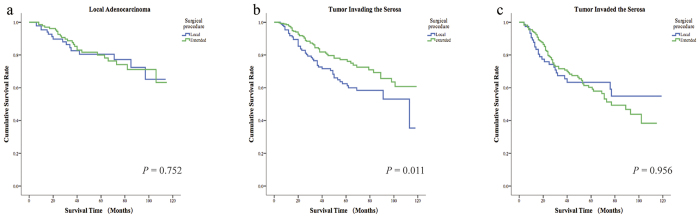
5-year overall survival of different surgical procedure according to different depth of tumor invasion.(a) For tumor did not invade the serosa, the 5-year overall survival had no significant difference of the two kinds of surgical approach. (b) For tumor was invading the serosa, the extended surgery had a significantly better 5-year overall survival. (c) For tumor had invaded the serosa, the 5-year overall survival had no significant difference of the two kinds of surgical approach.